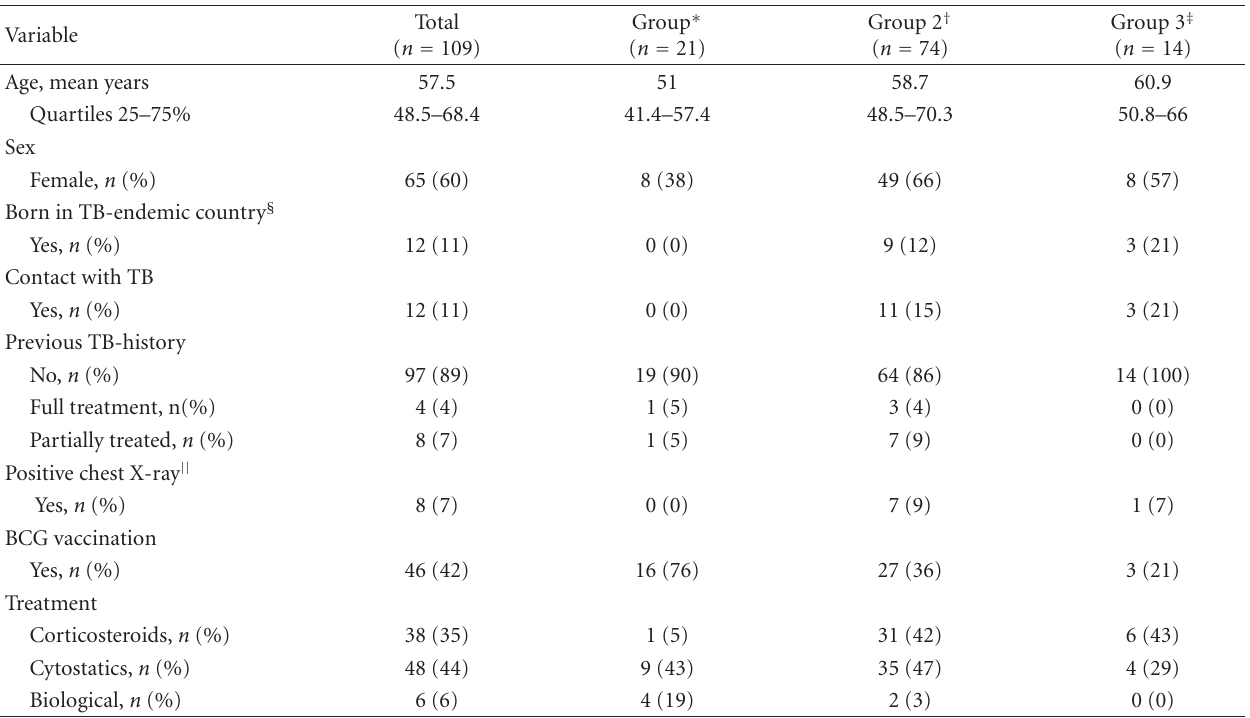
Table 1: Patient